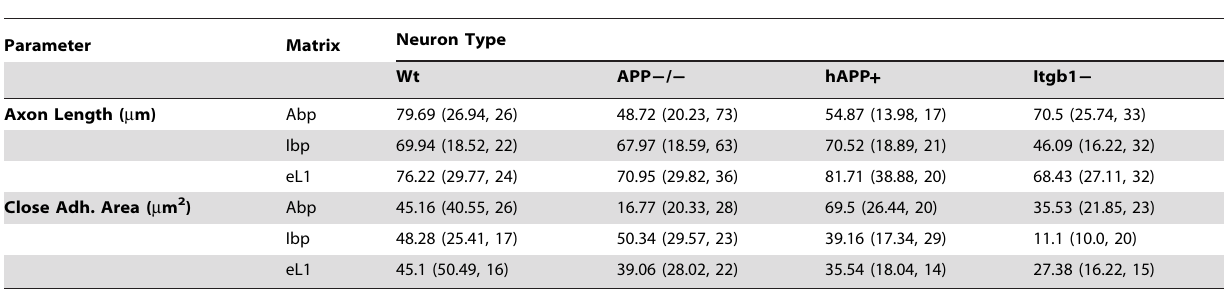
Table 3. GCs on Synthetic Matrices. Numerical Data: Mean (SD, N).